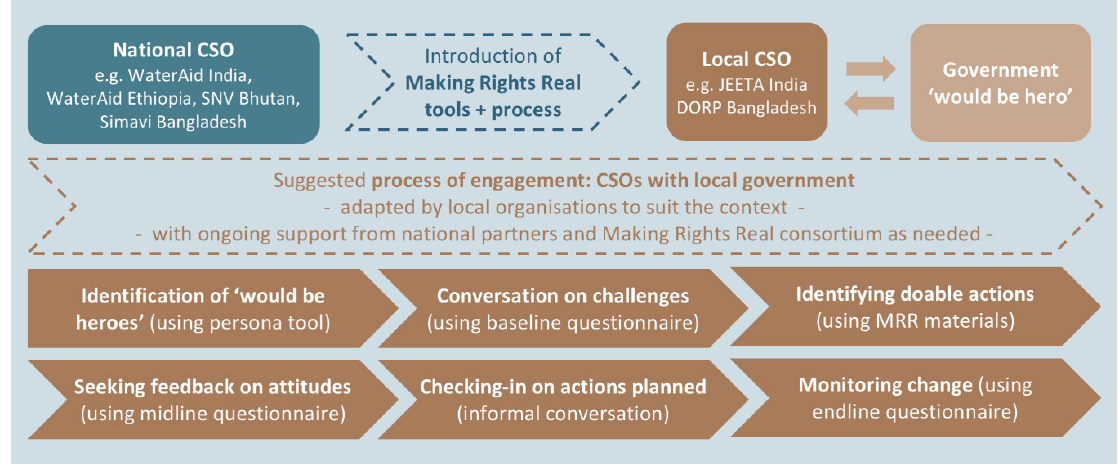
Figure 1. Suggested process for implementing the Making Rights Real (MRR) approach .